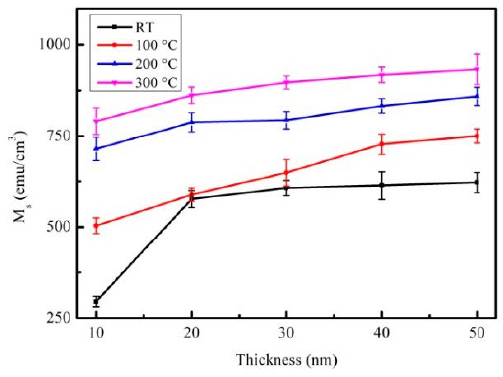
Figure 4. Saturation magnetization (M S ) of CoFeBY thin